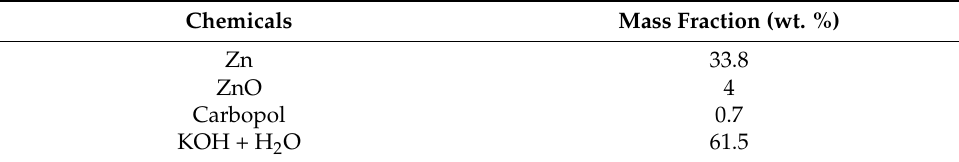
Figure 8. Schematic representation of the single cell Zn slurry–air flow battery with a flow frame [66]. Table 6. Composition of the Zn slurry